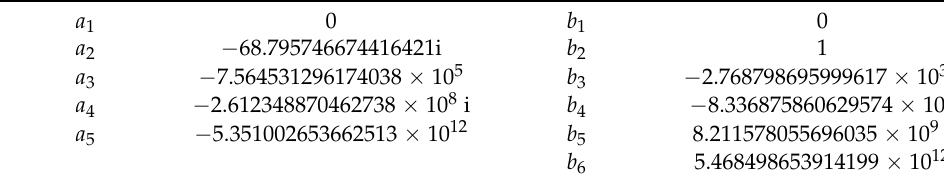
Table A2. Parameters for a forcing amplitude of 30%.